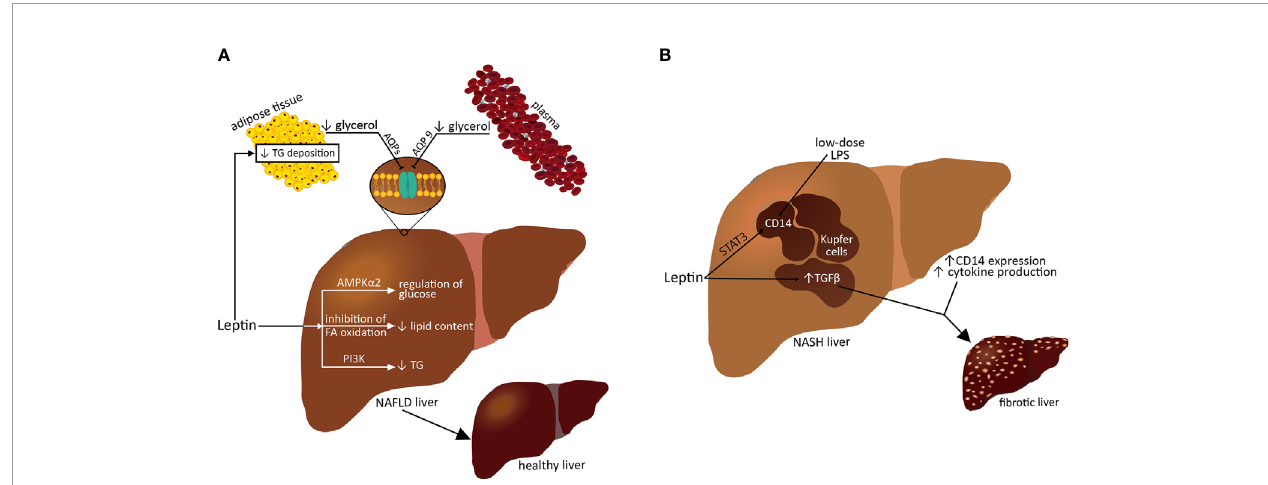
FIGURE 2 | Role of leptin in NAFDL/NASH